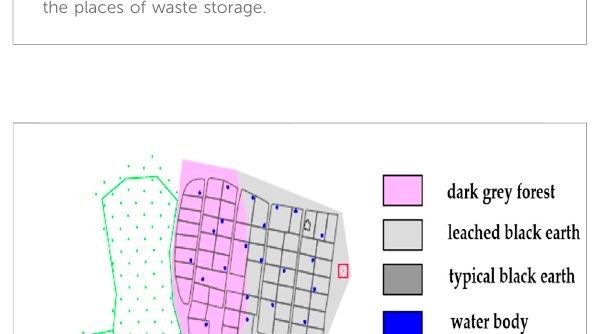
FIGURE 5 Graph of dependence of the market price on the distance to the places of waste storage.